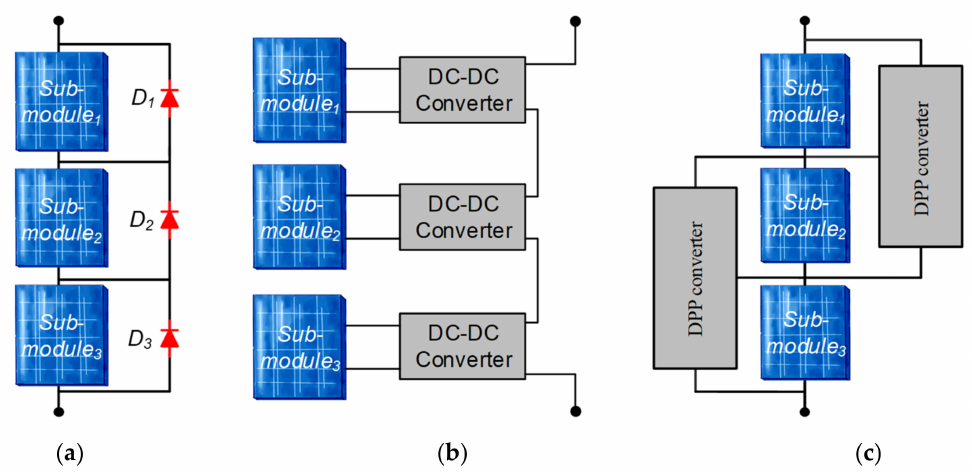
Figure 4. Mismatch reduction techniques: ( a ) bypass diodes, ( b ) DC optimizers, and ( c ) differential power processing (DPP)